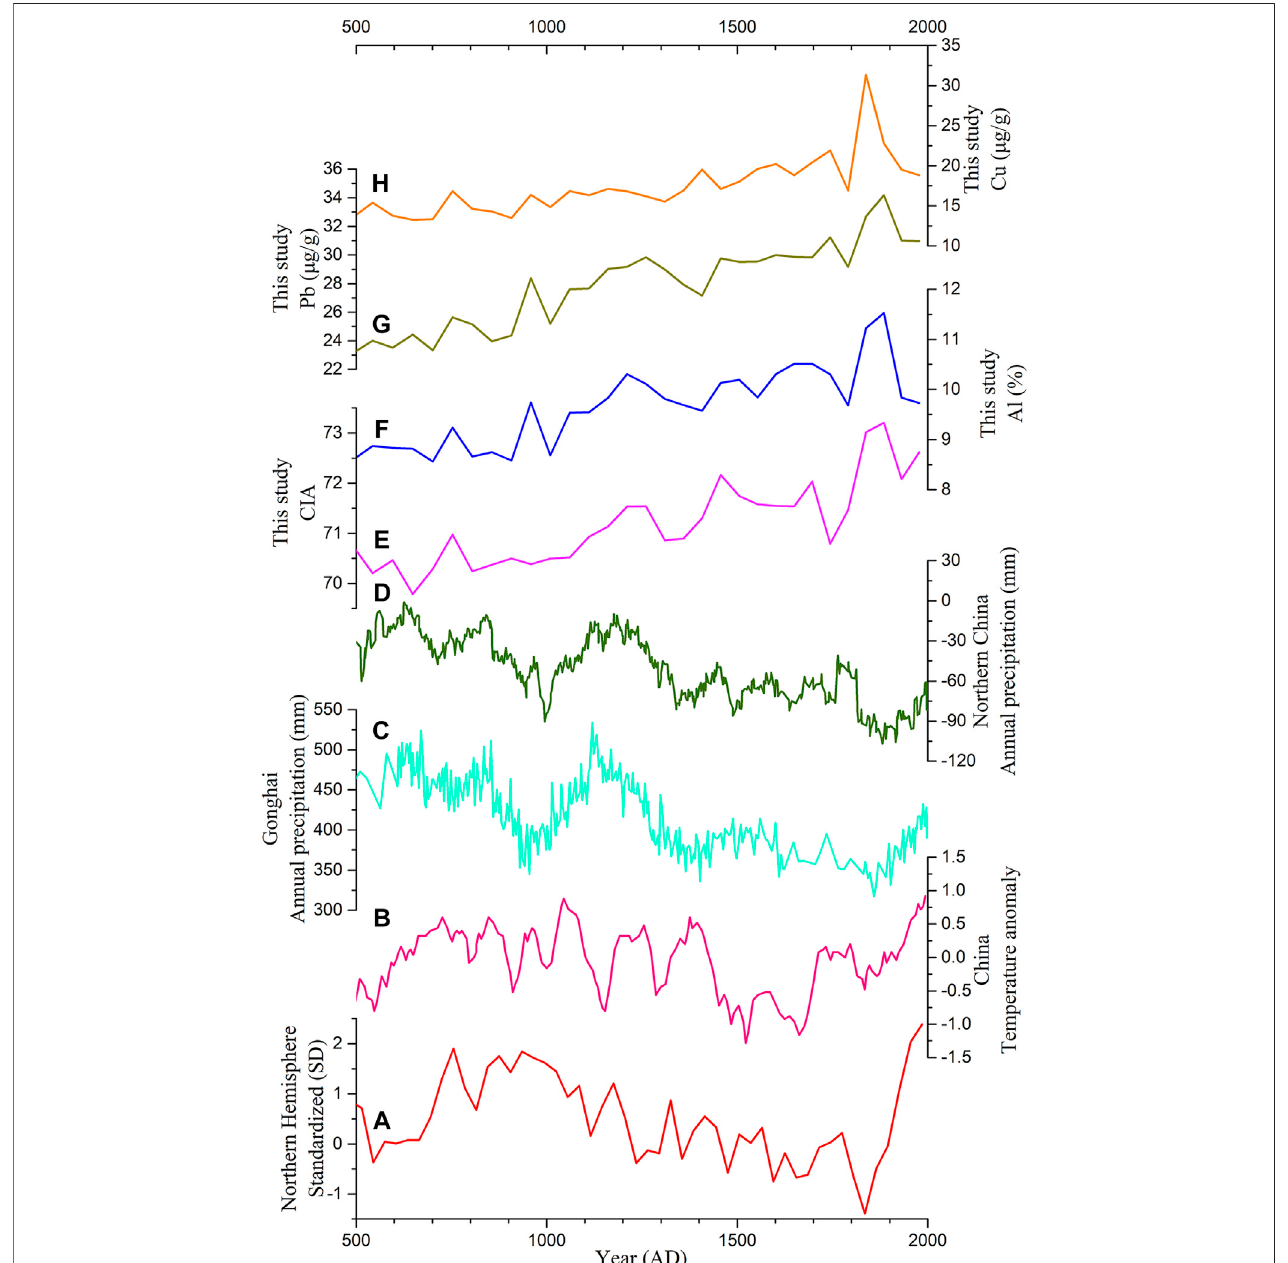
FIGURE 6 | Comparison between GH6 core records and temperature and precipitation data: (A) standardized 30-years-mean temperature record averaged over the whole Northern Hemisphere (PAGES 2k Consortium, 2013); (B) temperature reconstructions for the whole of China (Yang et al., 2002); (C) pollen-inferred annual precipitation data from Gonghai Lake (Chen et al., 2015); (D) KCM-based annual precipitation record for northern China (Li et al., 2017b); (E – H) multiple proxies from GH6 core.